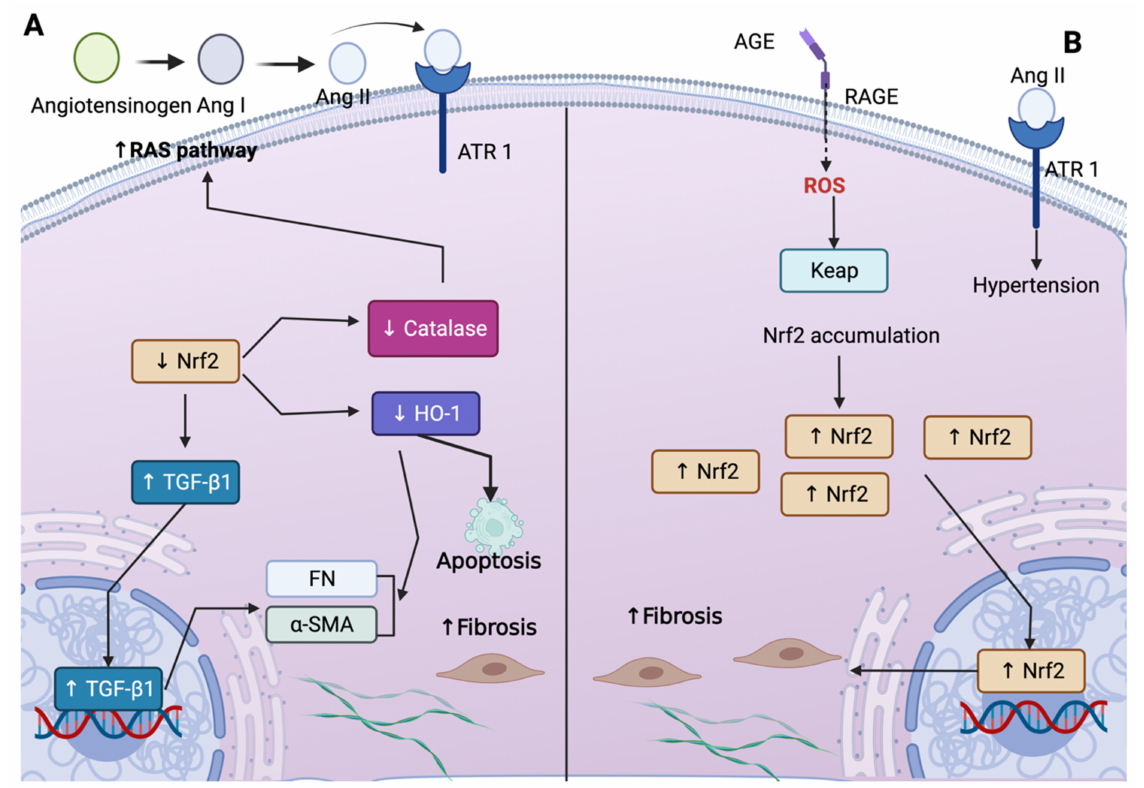
Figure 3. Differing scenarios for nuclear factor erythroid 2-related factor 2 (Nrf2) activation in renal fibrosis. ( A ) The downregulation of Nrf2 ( ↓ Nrf2) induces the upregulation of the transcription growth factor-beta1 ( ↑ TGF- β 1), inducing fibrosis by promoting the production of fibronectin (FN) and alpha-smooth muscle actin ( α -SMA). In addition, ↓ Nrf2 leads to the downregulation of catalase ( ↓ catalase), upregulating the generation of angiotensinogen, which converts into angiotensin II (Ang II). Then, Ang II interacts with angiotensin receptor 1 (ATR1), upregulating the RAS pathway. Nrf2 downregulation also induces the decrease in heme oxygenase-1 ( ↓ HO-1), promoting apoptosis and fibrosis. ( B ) In contrast, the upregulation of Nrf2 ( ↑ Nrf2) induces fibrosis and hypertension. This mechanism is attributed to ROS overproduction, generated via advanced glycation end products (AGEs) by binding to its receptor (RAGE), which activates Nrf2. This mechanism induces Nrf2 translocation to the nucleus with the positioning in Ang/ACE promoter, which leads to fibrosis [38]. The figure was created using